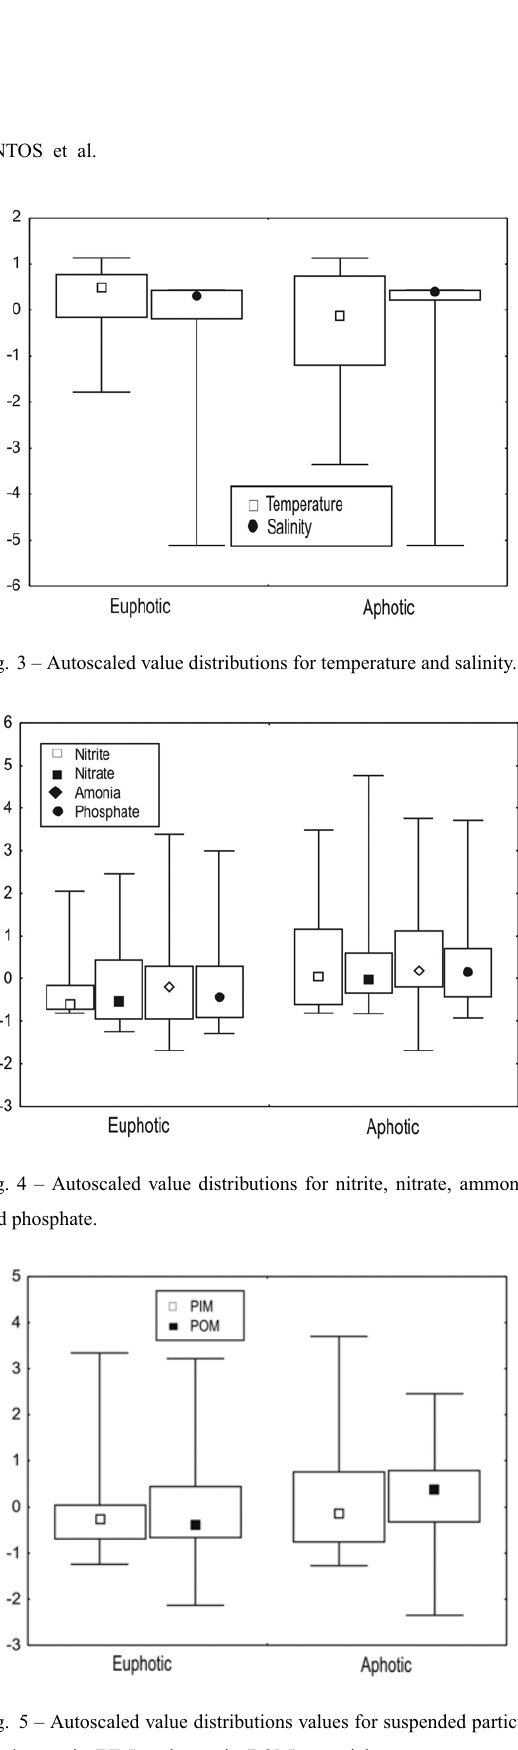
Fig. 5 – Autoscaled value distributions values for suspended particu- late inorganic (PIM) and organic (POM)